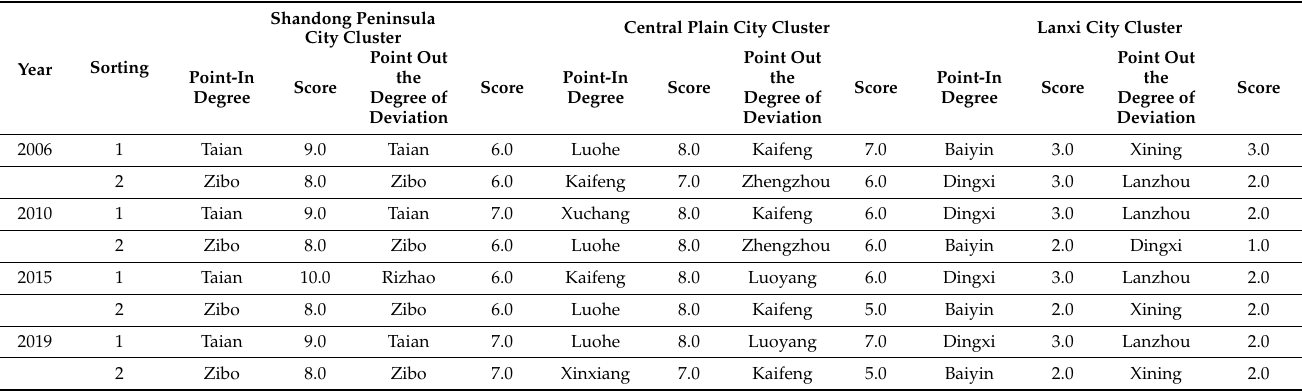
Table 3. Centrality of carbon emission efficiency networks in three major urban agglomerations.